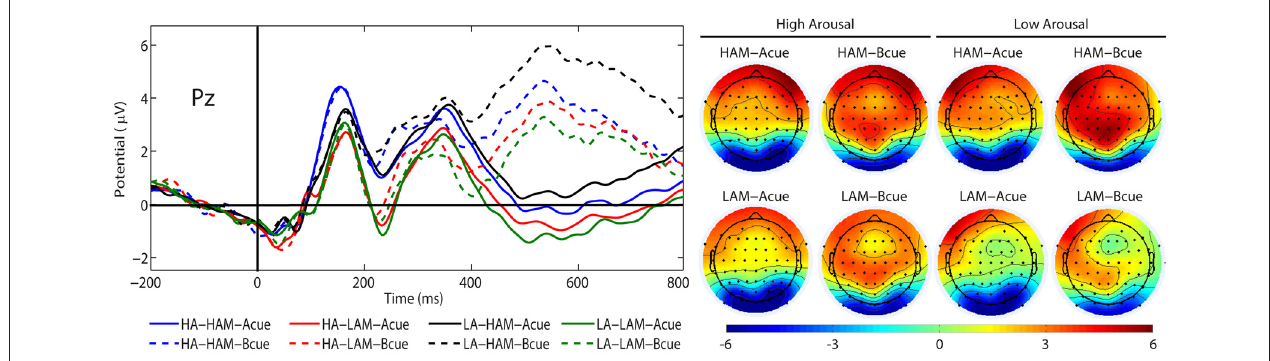
FIGURE 5 | Grand average event-related brain potentials (ERPs) (P3b) and topographical maps elicited by the A cue (solid lines) and the B cue (dashed lines) at Pz, separately for low (LA) and high (HA) arousal and low (LAM) and high (HAM) motivated positive affect.